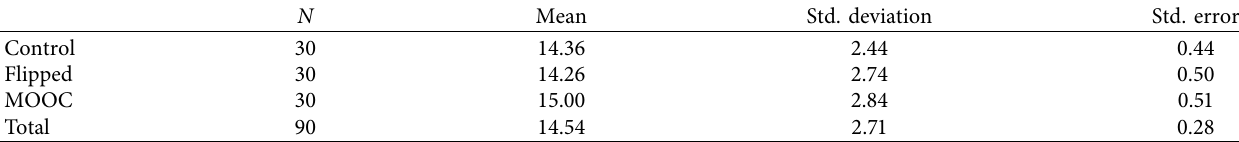
Table 1: Descriptive statistics of reading comprehension pretest.